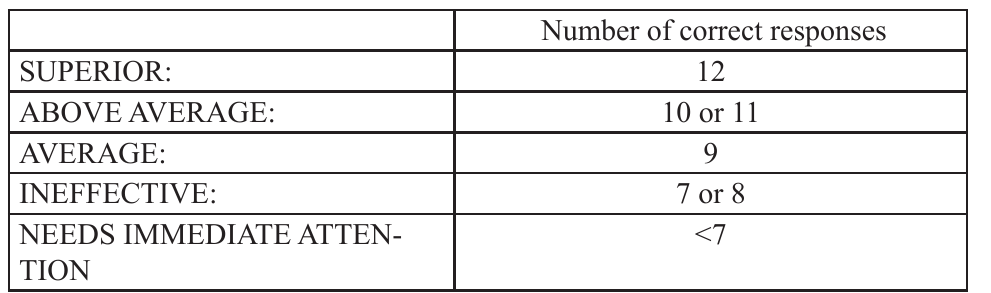
Table 14: The norms obtained for Visualization with the use of the Getman Manipulation Test